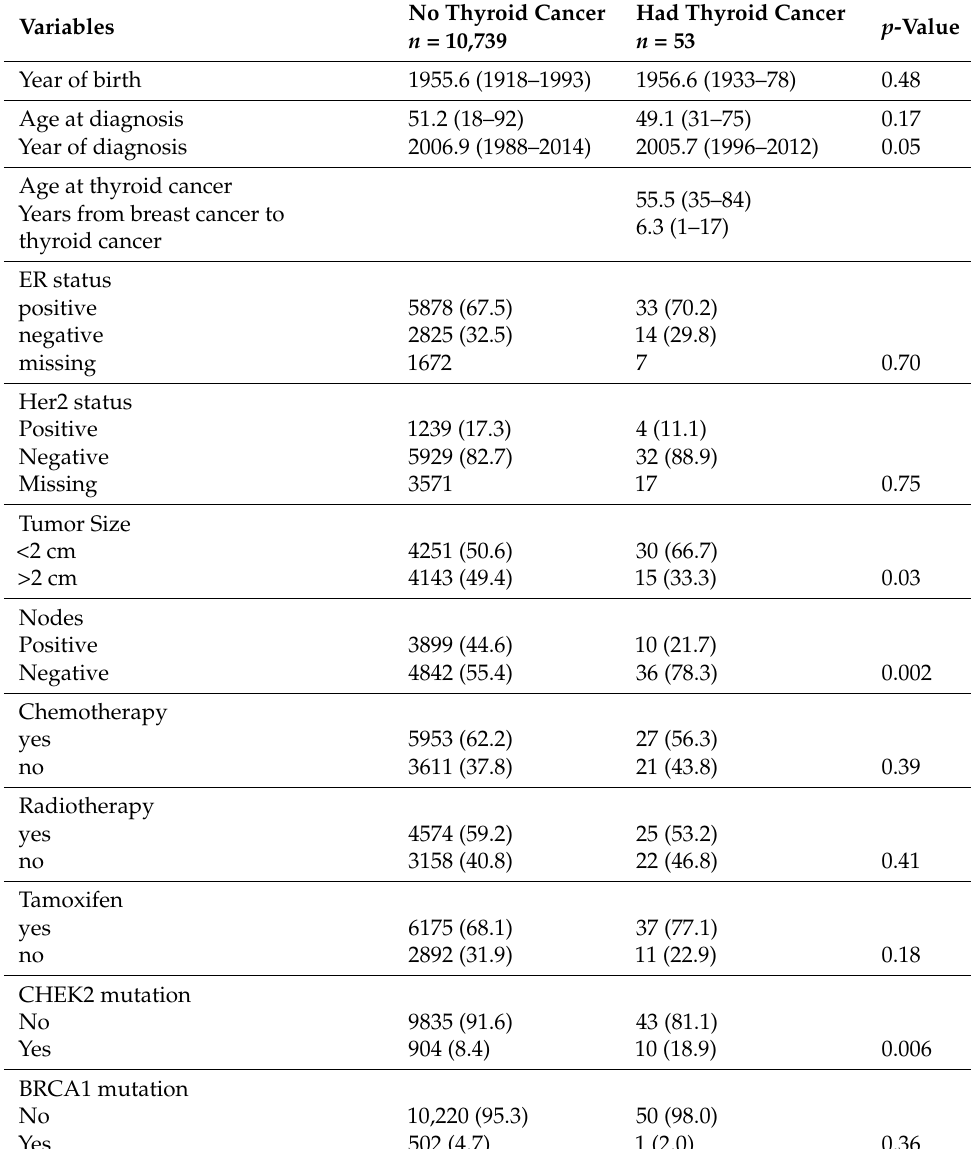
Table 1. Comparison of subjects with or without thyroid cancer after breast